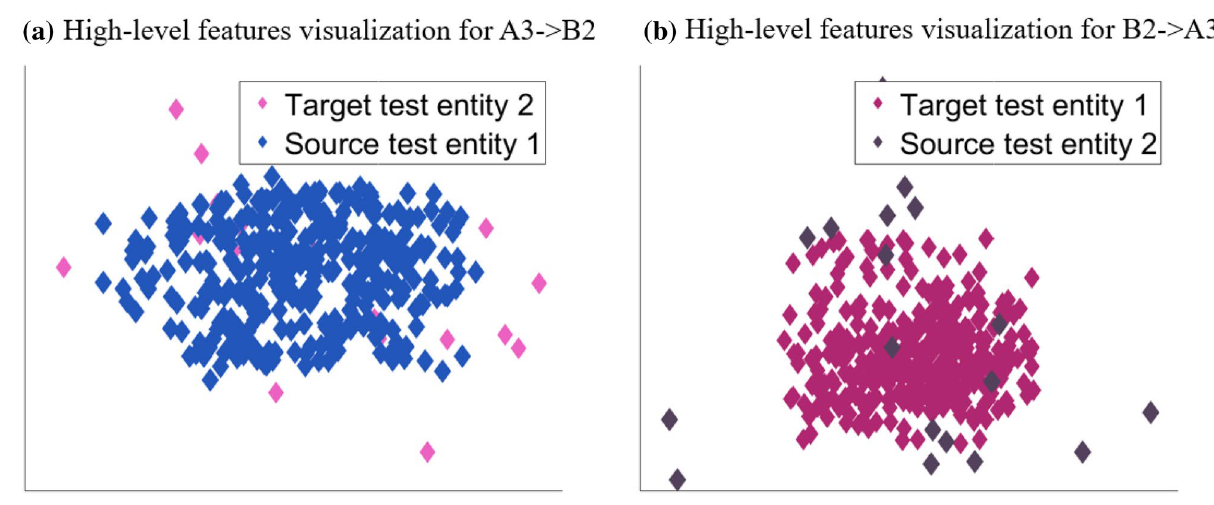
Figure 8. The feature visualization for